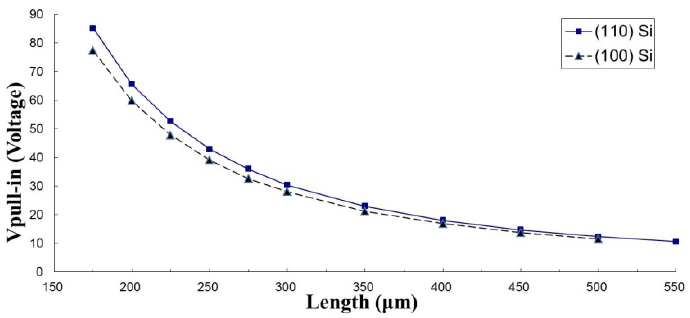
Figure 7. The measured the pull-in voltages of the fixed-fixed beams made of mono-crystalline siliconin (100) and (110) orientations in Osterberg’s work [9].